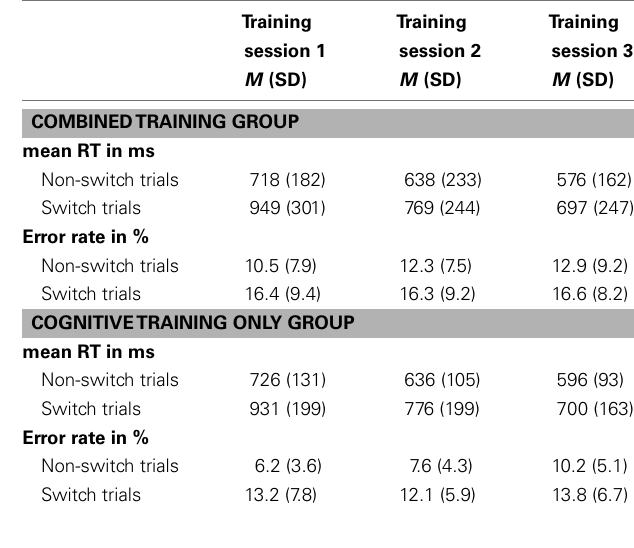
Table 2 | Mean RT and error data for task switching training task in all three training sessions for the combined and the cognitive training only